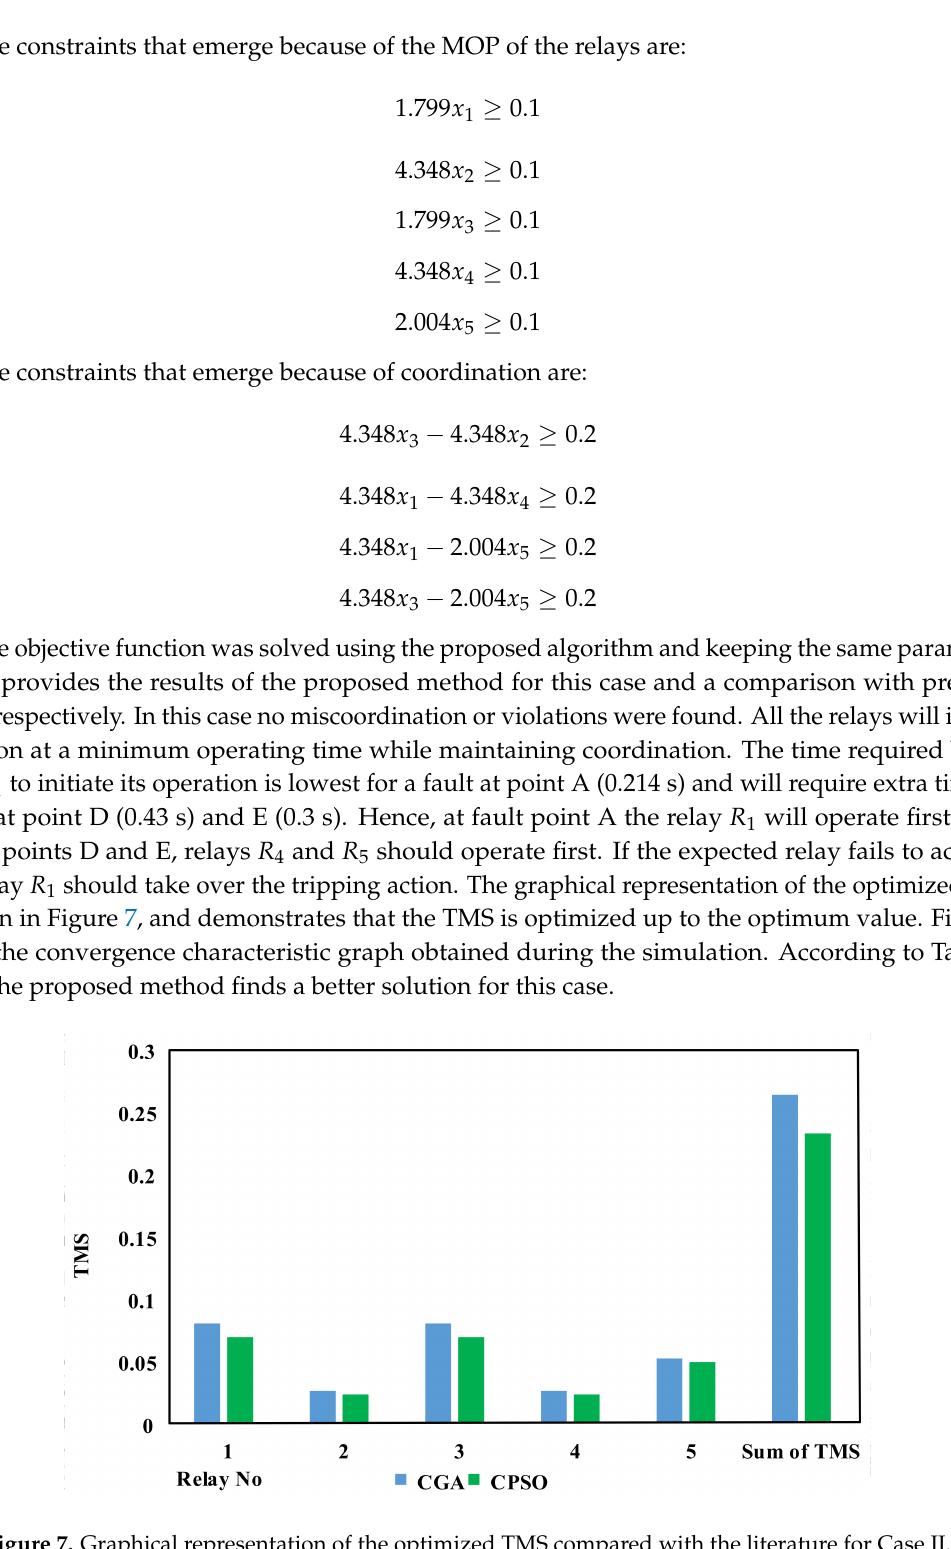
Figure 7. Graphical representation of the optimized TMS compared with the literature for Case